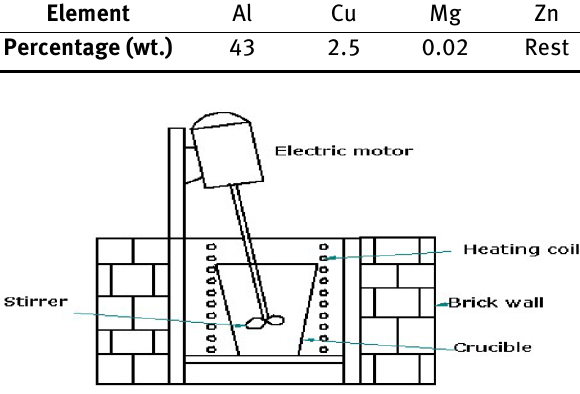
Table 1: Composition of matrix in their weight percentages Element